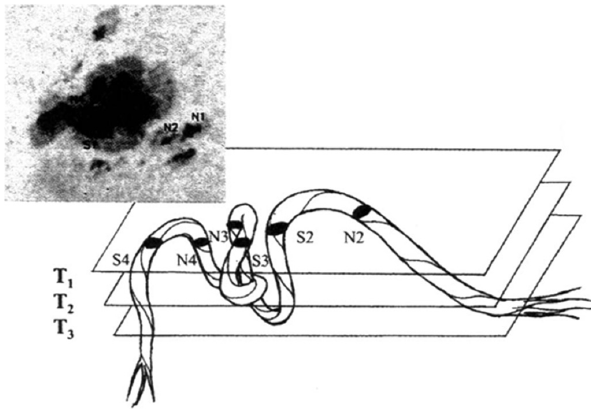
Fig. 6b. Attempt to explain the structure of a sunspot group on the basis of a flux tube concept (Deng et al., 2005).